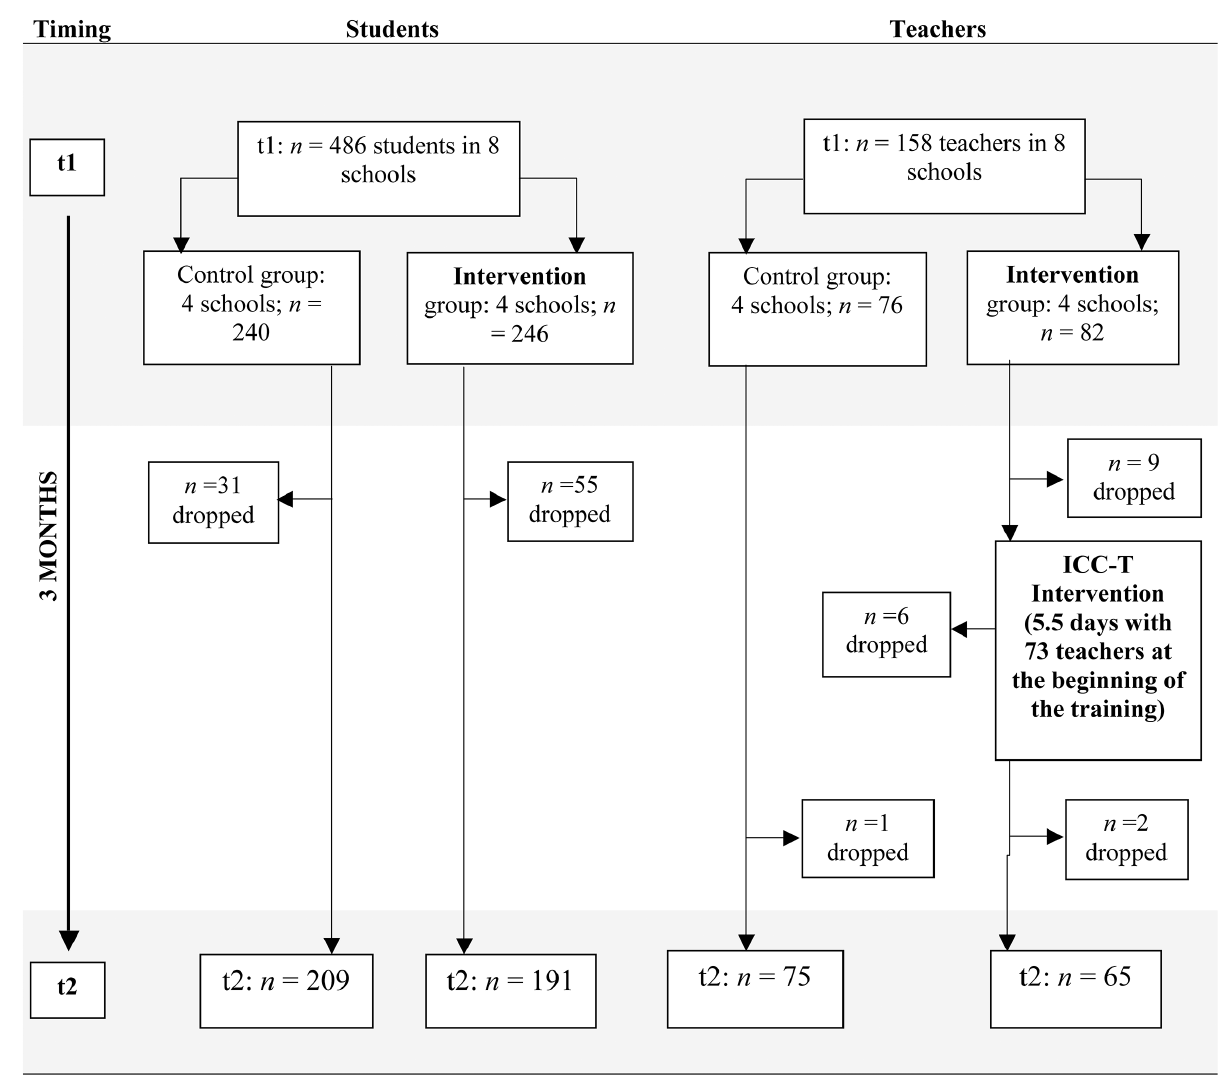
Fig 1. Flow-chart of the study